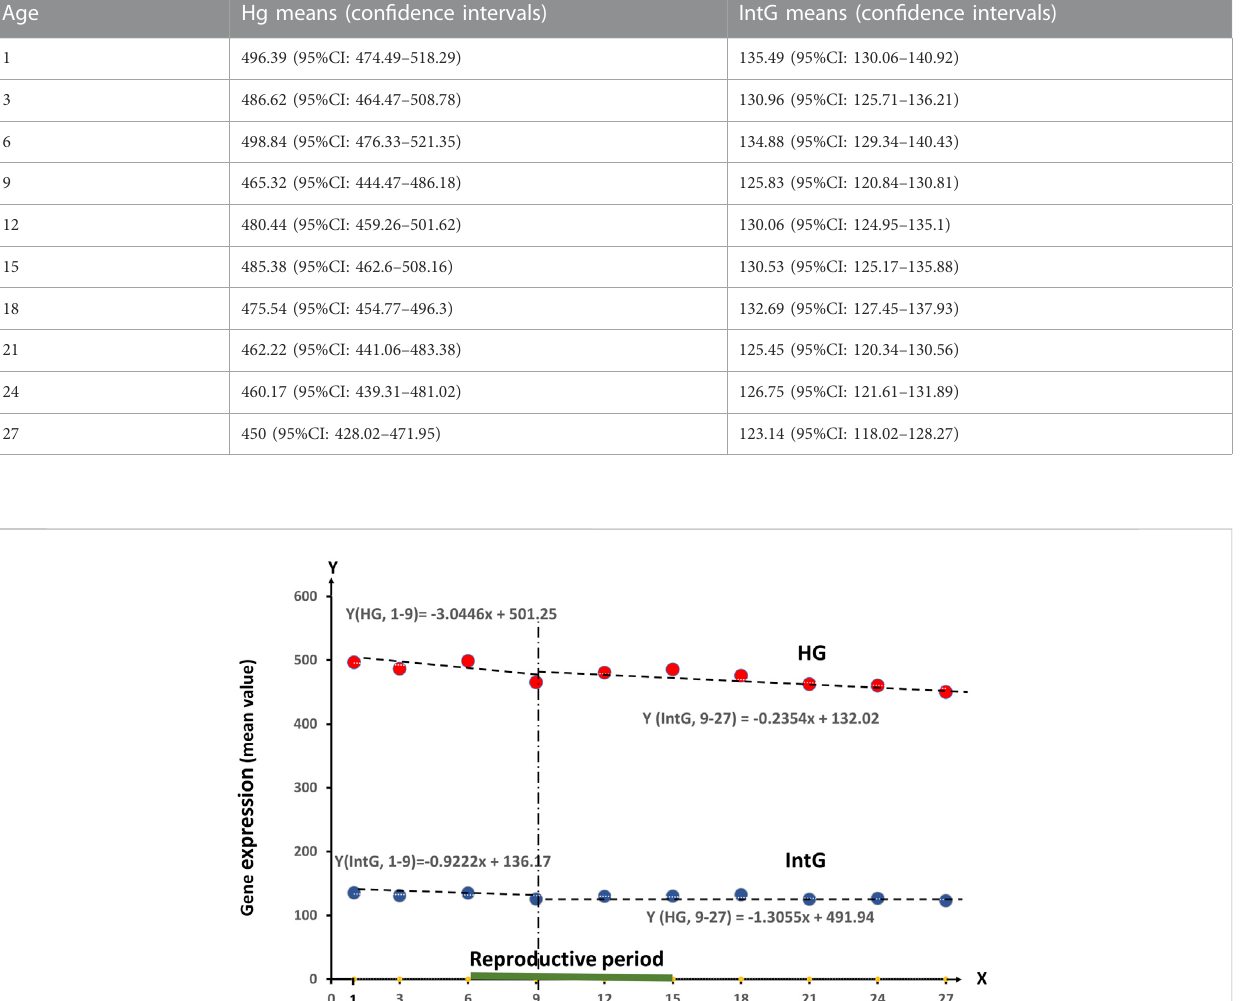
TABLE 1 Total average values (and their con fi dence intervals) of RNA production in all tissues in the HG and IntG groups during the observation period of age. Age Hg means (con fi dence intervals)